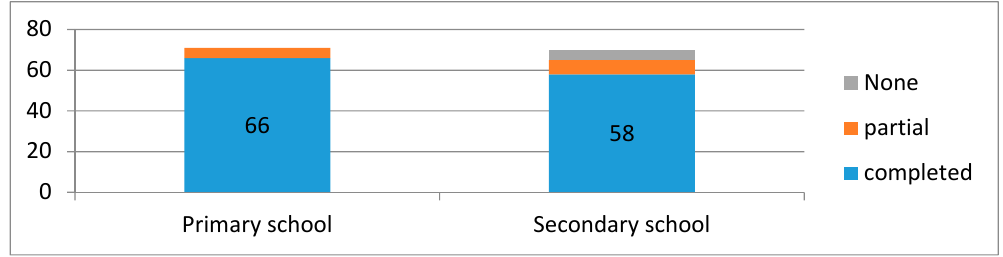
Figure 1. Music education at primary and secondary school.